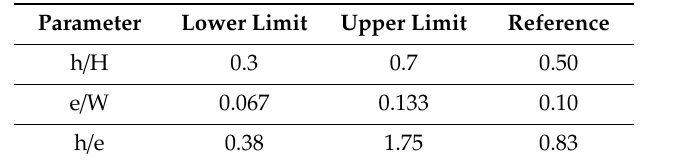
Table 2. Ranges and reference values of geometric parameters.